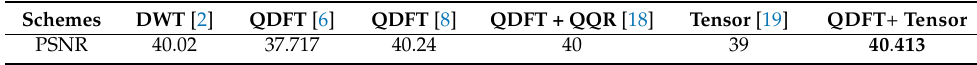
Table 2. Comparison of proposed scheme with existing schemes in the field of imperceptibility.